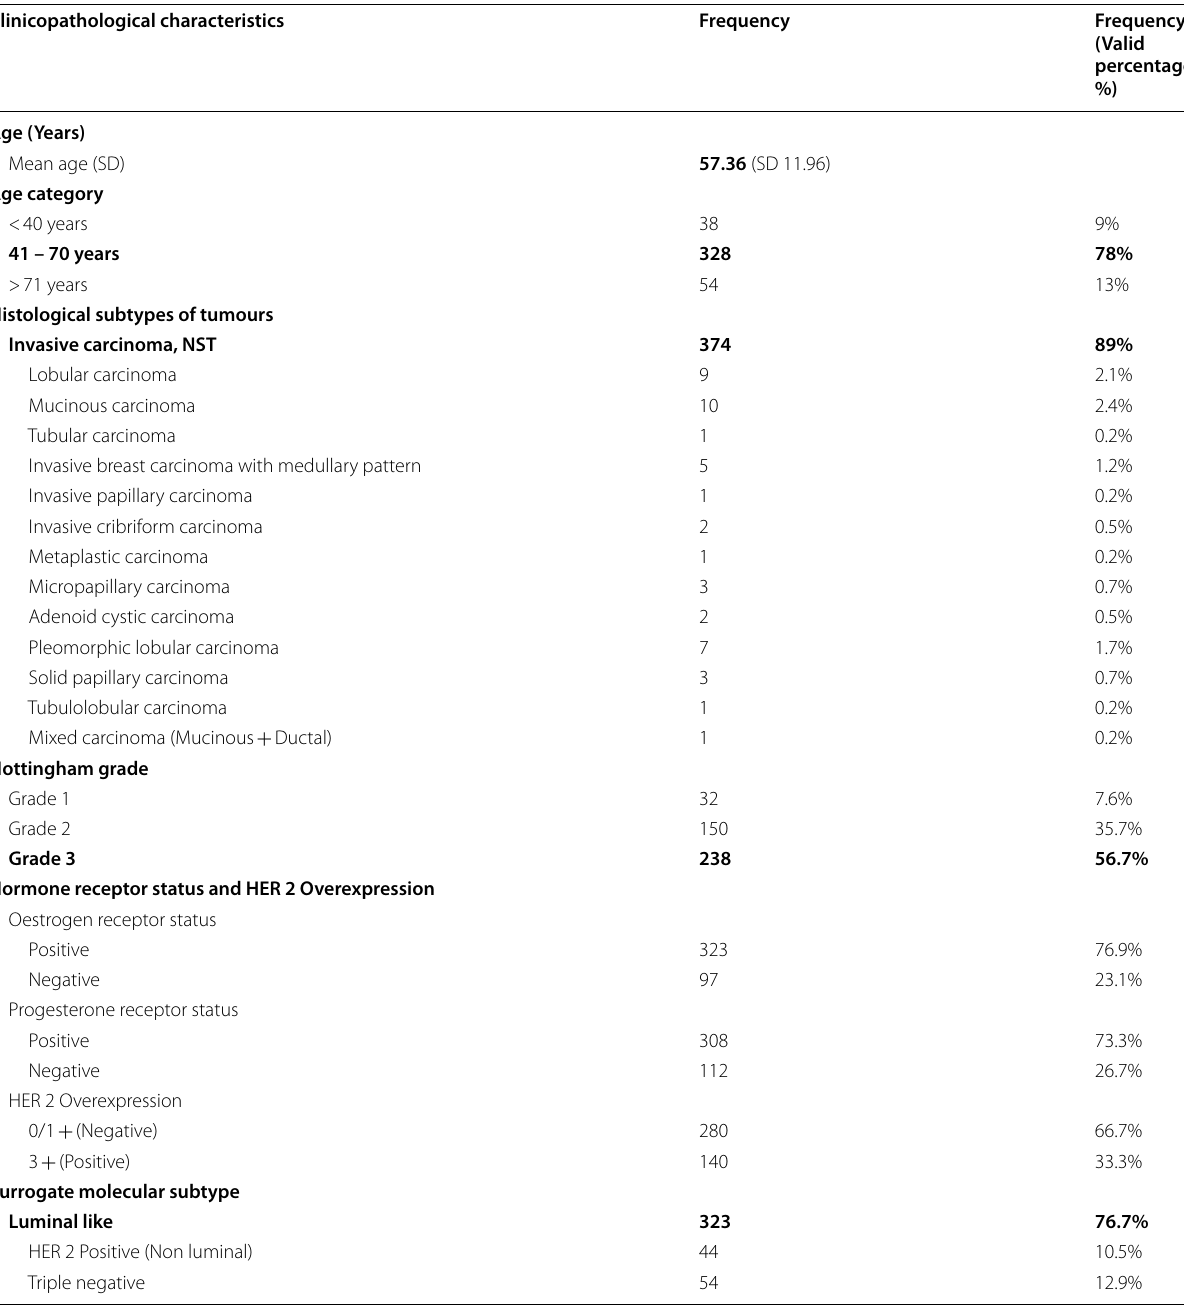
Table 1 Clinicopathological characteristics of the breast carcinoma study population Clinicopathological